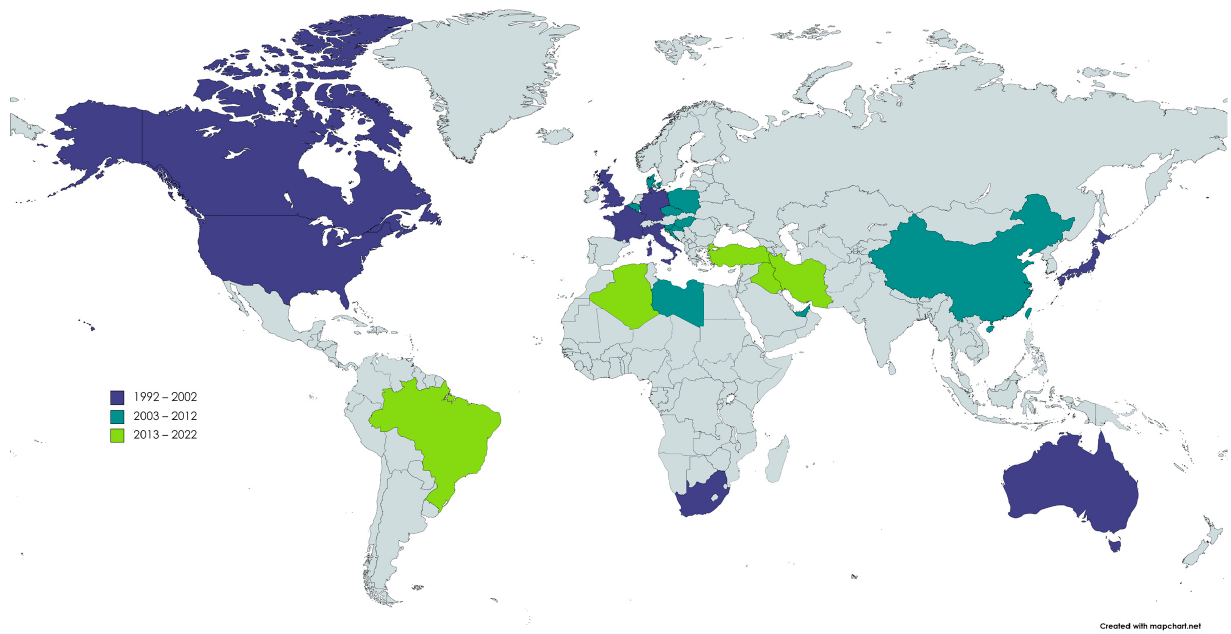
Figure 5. Countries with reported detection of PiCV colored according to the earliest retrieved record of detection